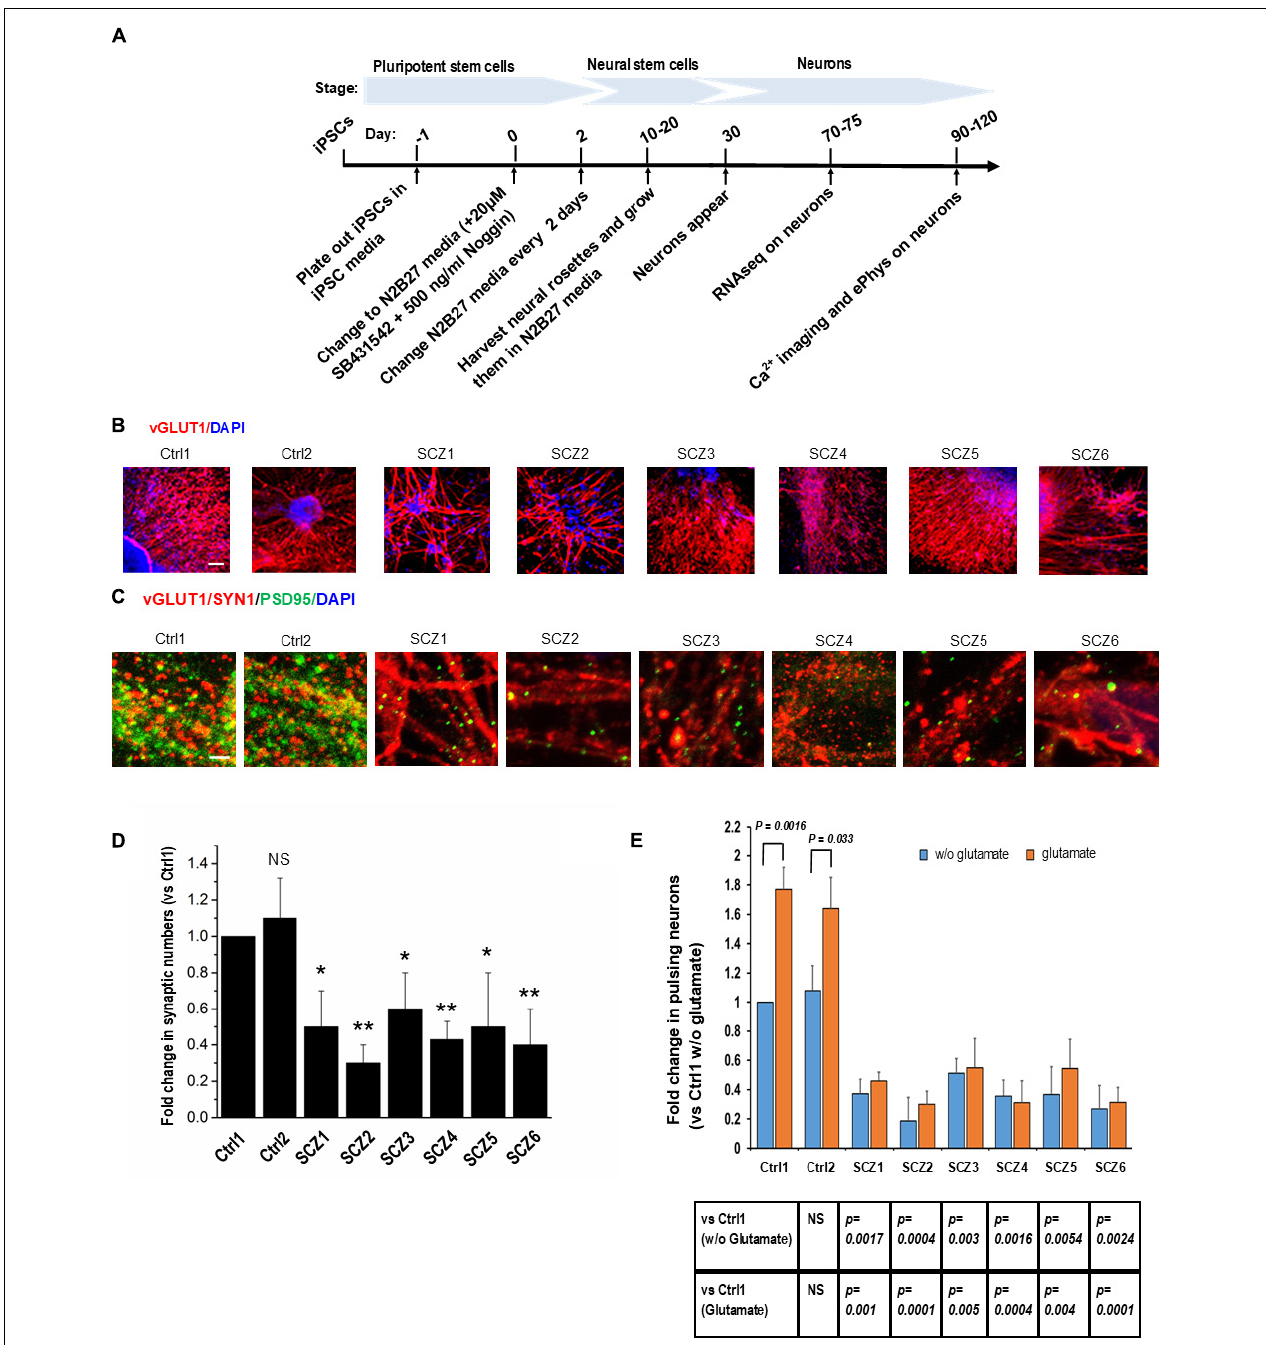
FIGURE 2 | Cell line characteristics. (A) Timeline of the experiment. (B) Immunohistochemistry imaging of glutamatergic neurons derived from hiPSC lines (vGLUT1 antibody). (C) Immunohistochemistry imaging of postsynaptic densities of glutamatergic neurons (PSD95 antibody). (D) Number of postsynaptic densities of glutamatergic neurons. (E) Ca imaging, number of the ca transients and the effect of glutamate. CTRL, neurons from control subjects; SCZ, neurons from schizophrenia subjects. The symbols represent significance levels: * p < 0.05; ** p <